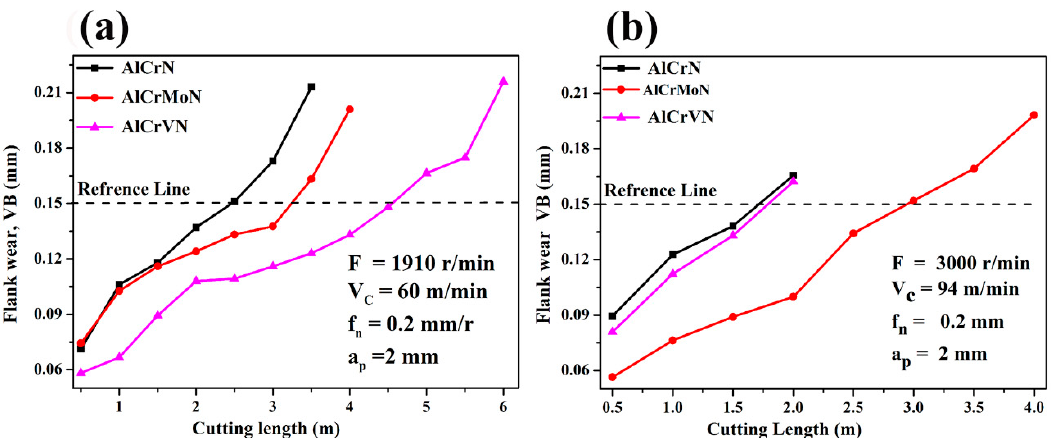
Figure 6. Cutting life curves of the coated HSS straight shank end milling cutter under different speeds ( a ) 60 m/min and ( b ) 90 m/min.